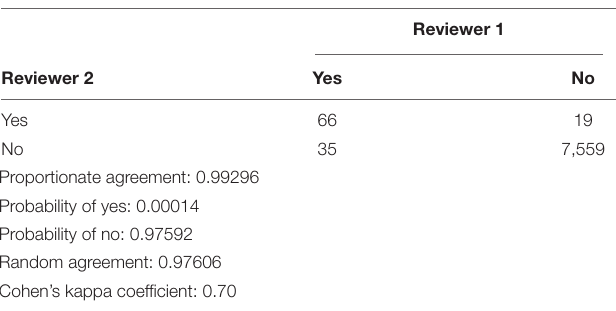
TABLE 2 | Measurement of inter-rater reliability. Measurement of inter-rater reliability at title and abstract level